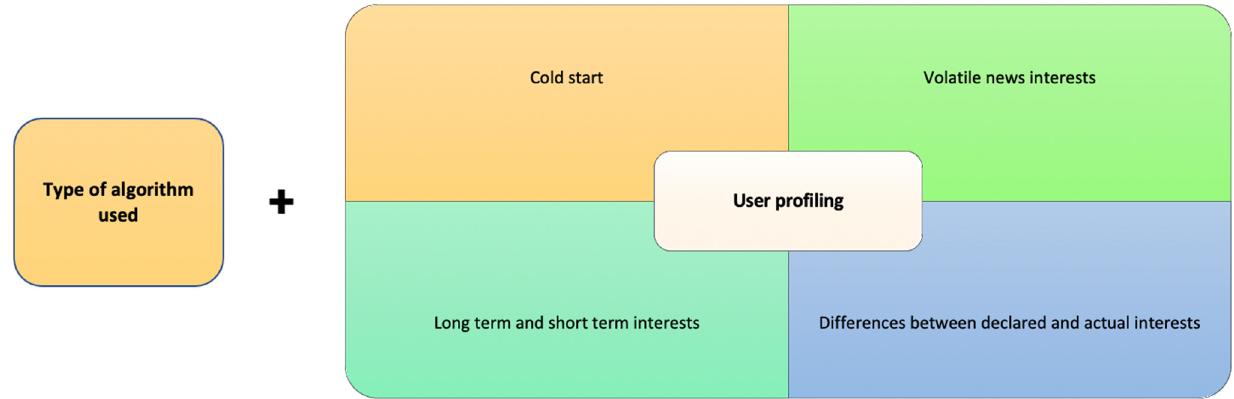
Figure 3. Challenges relating to user profiling in news recommender systems.